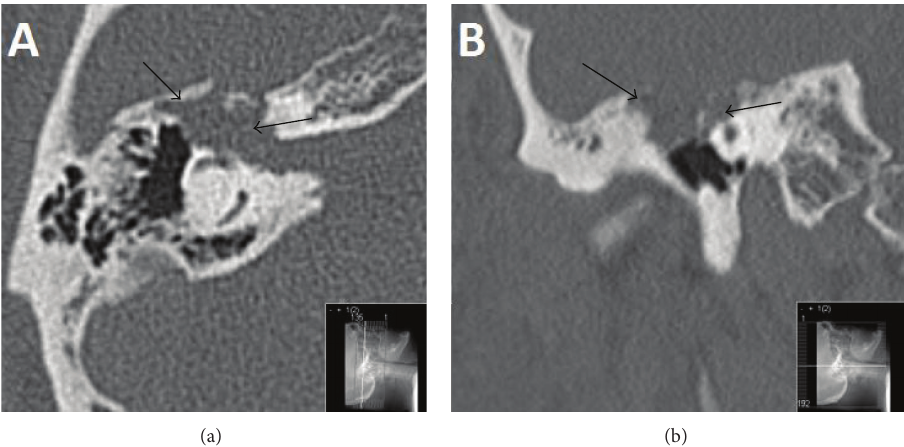
Figure 1: Axial (a) and coronal (b) CT images demonstrating a destructive abnormality ( black arrows demarcating extent ) involving the right geniculate ganglion extending into the right attic and eroding the bone around the right cochlea.